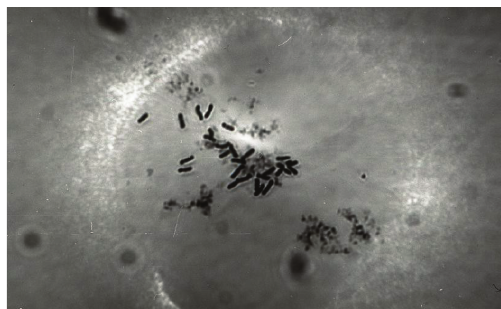
Figure3:( 10×40) , 2𝑛 = 6𝑥 = 42 chromosomesbelongingtosample 419K of 446 P. pseudo orientale collected from Caldıran, Gulhisar, and Van provinces, Turkey, pretreated with 0 ∘ C melting ice for 24